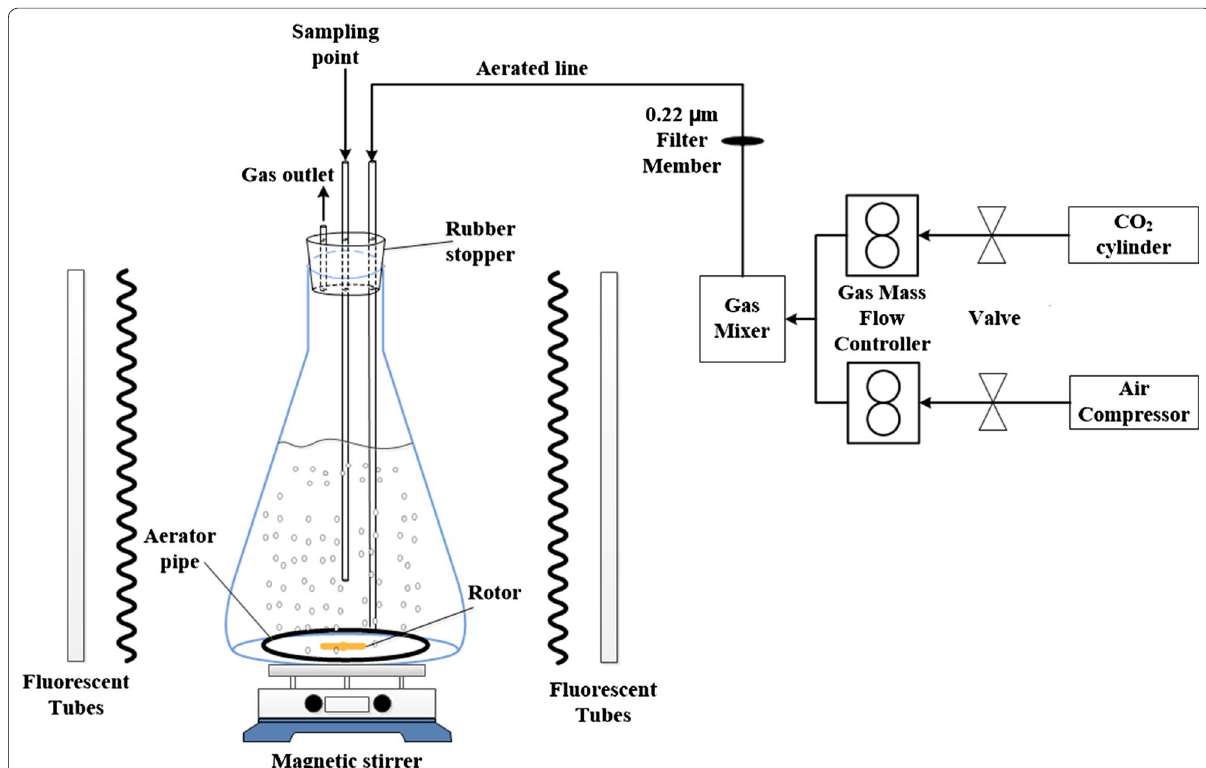
Fig. 1 Schematic diagram of the experimental set-up and instrumentation used